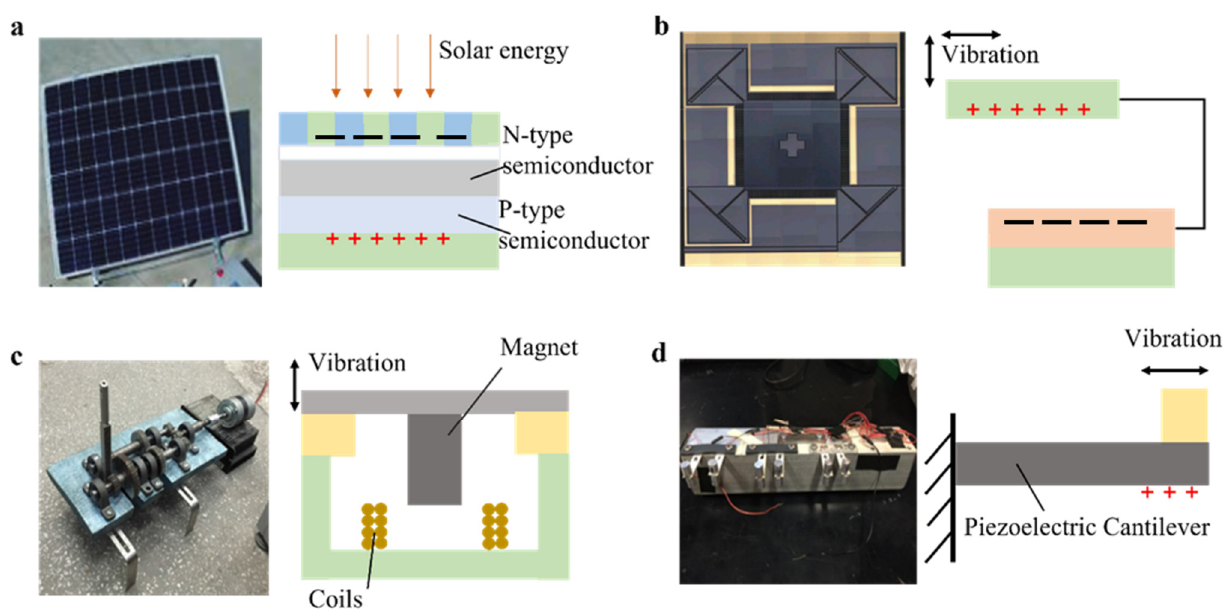
Figure 8. Principles of power generation. ( a ) Principle of solar energy harvester [34]. ( b ) Principle of electrostatic harvester [118]. ( c ) Principle of electromagnetic harvester [119]. ( d ) Principle of piezoelectric energy harvester [120].